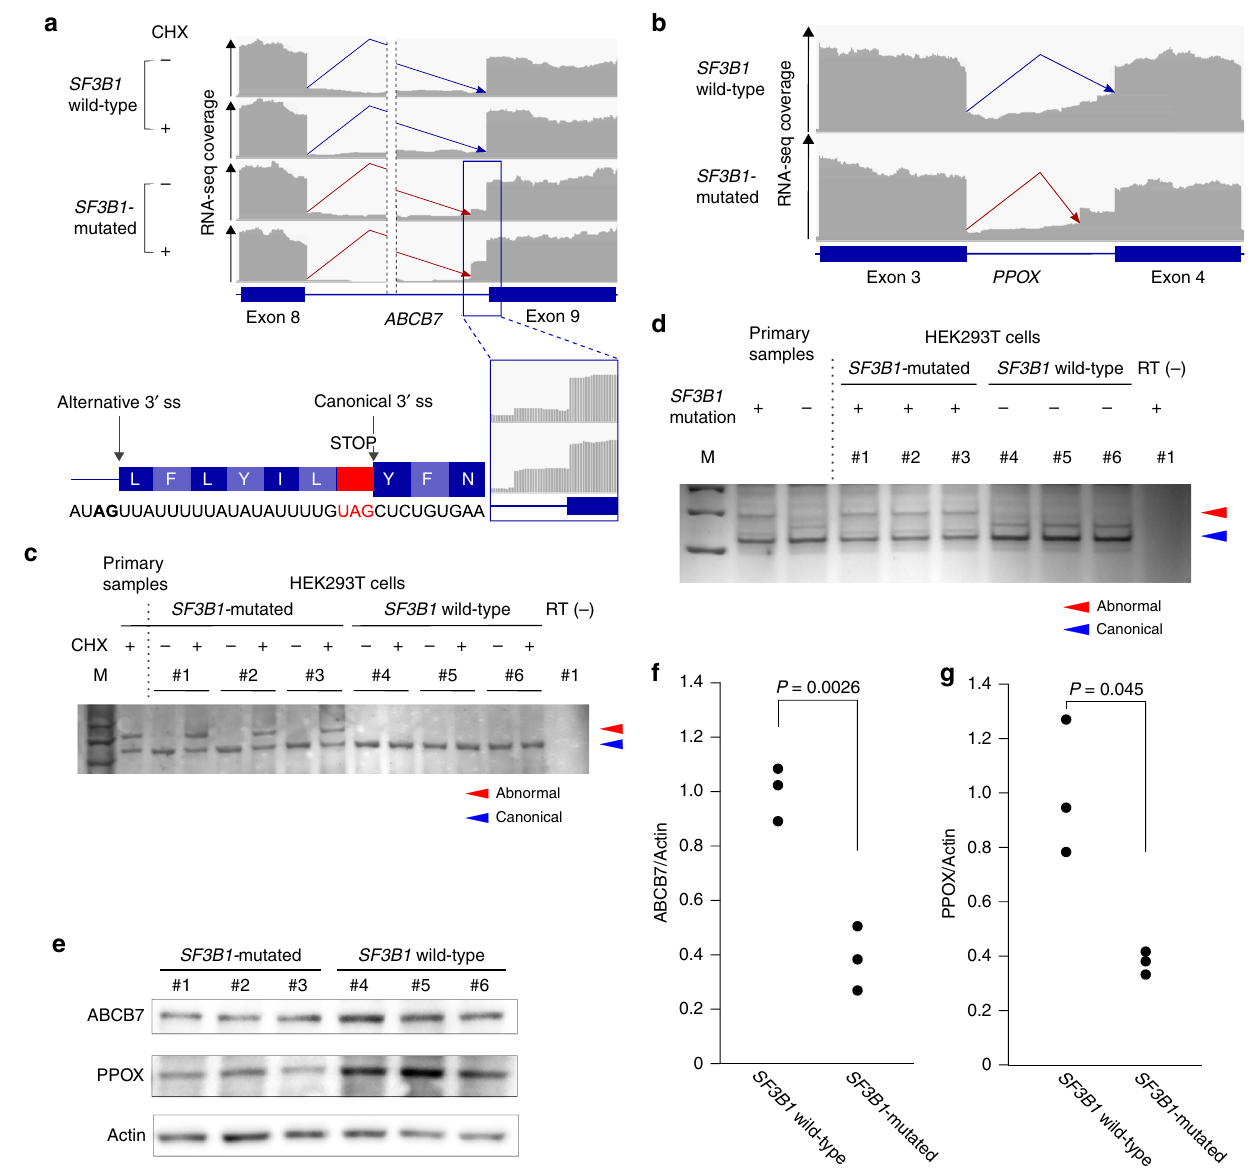
Fig. 7 Mutant SF3B1 -associated alternative 3 ′ splice sites. a , b Mutant SF3B1 -associated alternative 3 ′ splice sites in ABCB7 ( a ) and PPOX ( b ). RNA-seq coverage is shown for samples with mutated and wild-type SF3B1 , as well as for those with and without CHX treatment only in a . The bottom fi gure in a illustrates an RNA sequence, a spliced transcript, and the corresponding amino acids near the 3´ splice site of exon nine of ABCB7 . c , d RT-PCR of the differentially spliced sites of ABCB7 ( c ) and PPOX ( d ). RT-PCR was performed for primary MDS samples and CRISPR cell lines with or without the SF3B1 K700E mutation. Clones #1 to #3 carried a heterozygous SF3B1 K700E allele, while clones #4 to #6 had only wild-type alleles. Samples without reverse transcription (RT) were used as a negative control. Samples treated with CHX are also shown in c . Canonical and abnormal transcripts are indicated by blue and red triangles, respectively. e Immunoblots of CRISPR cell lines with or without the SF3B1 K700E mutation. Lysates were processed for immunoblotting with antibodies against denoted proteins. f , g Relative protein levels of ABCB7 ( f ) and PPOX ( g ). The dot plots show protein levels in three independent clones. Statistical signi fi cance was determined by the unequal variance t -test; t -values were 6.9 ( f ) and 4.3 ( g